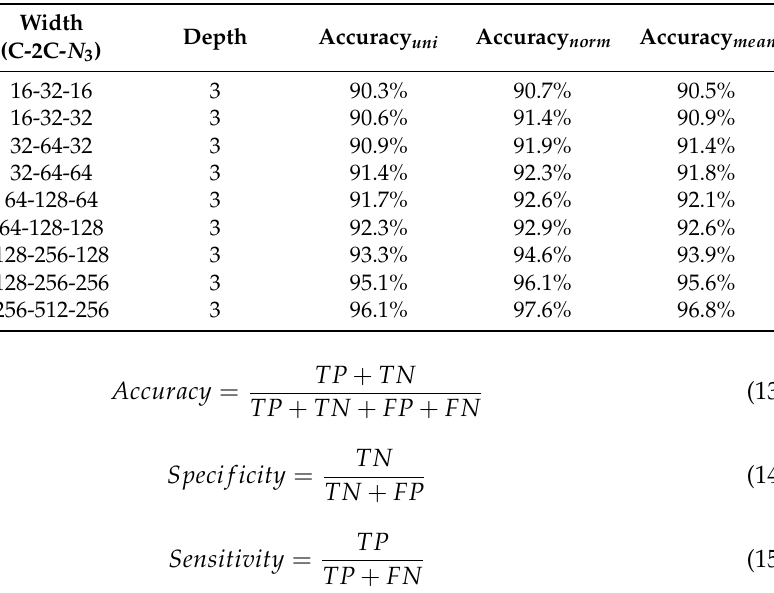
Table 1. Comparative analysis of the proposed scheme with different kernel sizes and width for uniform and normal